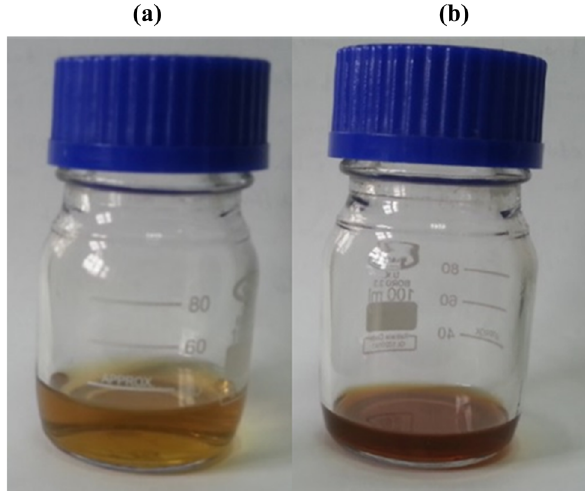
Figure 2: Color and appearance changes during the synthesis of Se NPs using the walnut leaf extract. The walnut leaf extract containing selenium salt before ( a ) and after ( b ) exposure to microwave irradiation.